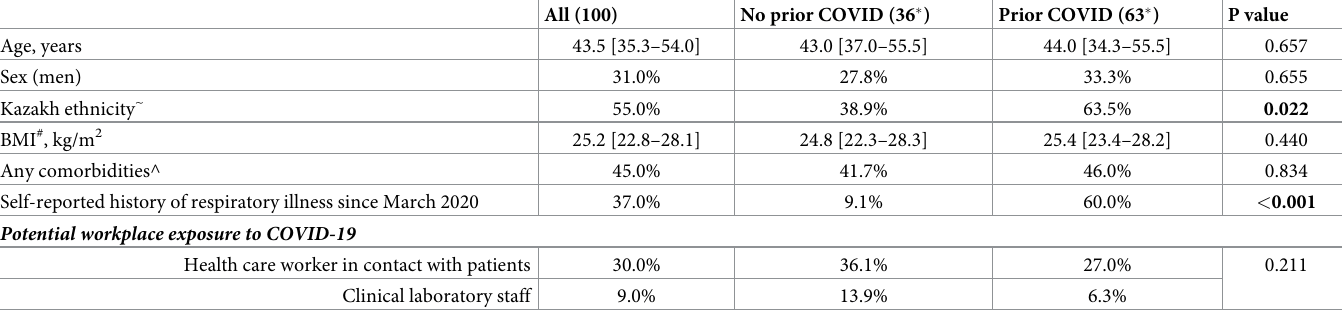
Table 1. Demographic and clinical characteristics of the study